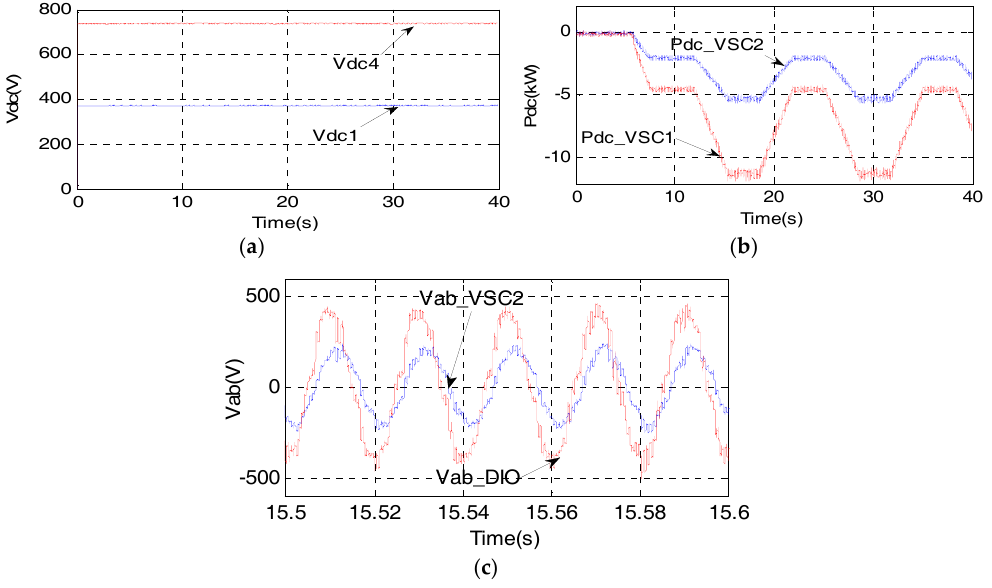
Figure 13. Experimental results of DUDAT. ( a ) DC voltages at DC terminal of VSC1 and VSC4; ( b ) DC power of VSC1 and diode bridge; ( c ) line-line AC voltage of VSC2 and diode bridge.